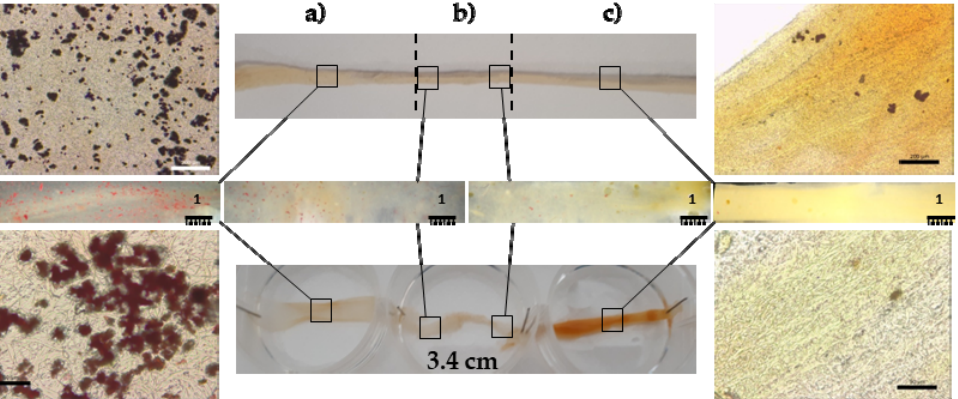
Figure 5. Optical images of Alizarin Red staining of the tubular scaffold: a) R-HAP part; b) interface; c) A-B part.